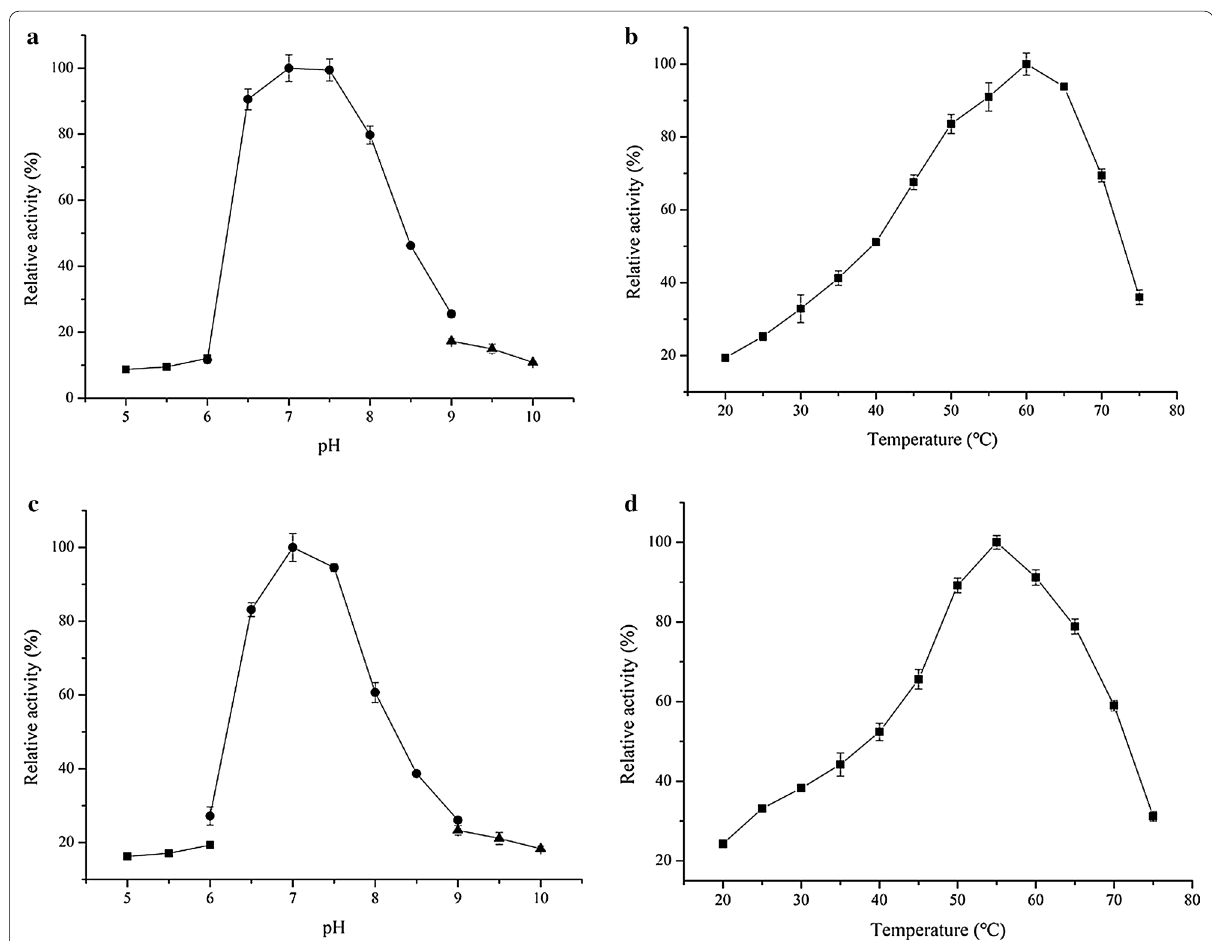
Fig. 2 Enzymatic characteristics of PW-xyl9 and PW-xyl37. a Optimal pH value for PW-xyl9. b Optimal temperature value for PW-xyl9. c Optimal pH value for PW-xyl37. d Optimal temperature value for PW-xyl37. The pH range was 5–10, and the buffer systems used were: citrate–phosphate ( ■ ) for the pH 5–6 range, Tris–HCl ( ● ) for the pH 6–9 range, glycine–NaOH ( ▲ ) for the pH 9–10 range. The value represents the mean value of triplicate experiments, and the error bar indicates standard deviation